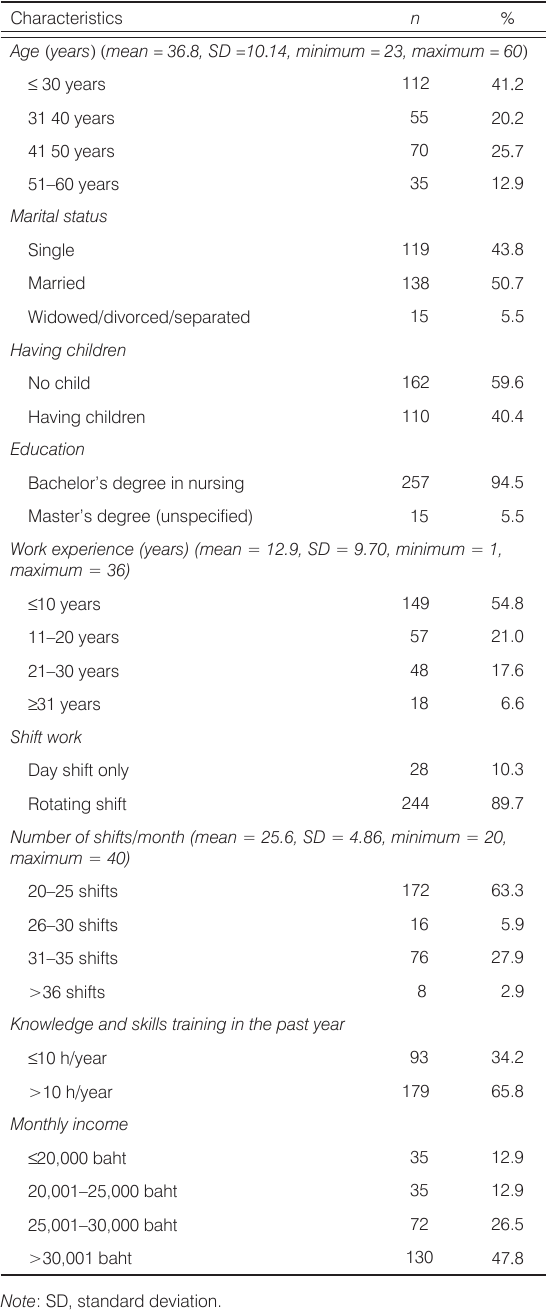
Table 1. The demographic characteristics of the participants ( n =